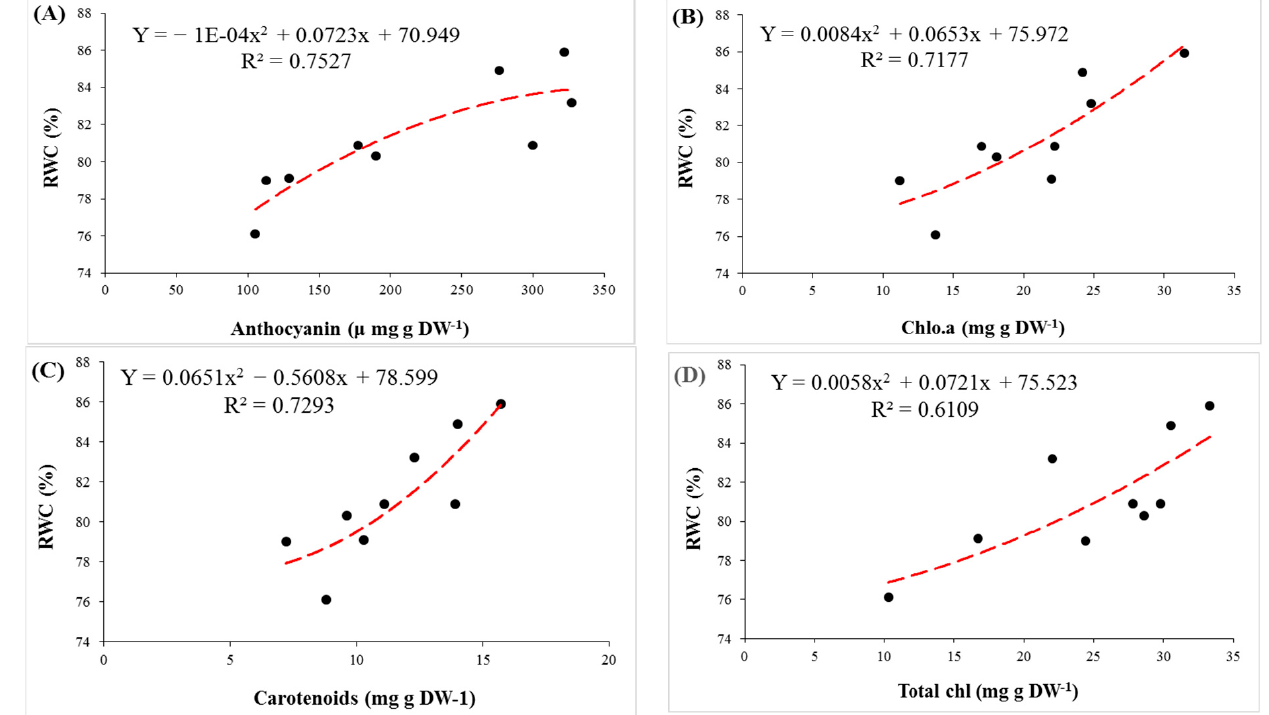
Figure 6. The regression between concentrations of plant pigments (anthocyanin ( A ), chlorophyll a ( B ), carotenoids ( C ) and total chlorophyll ( D )) and relative water content (RWC) in leaves of pistachio rootstocks under salinity stress.